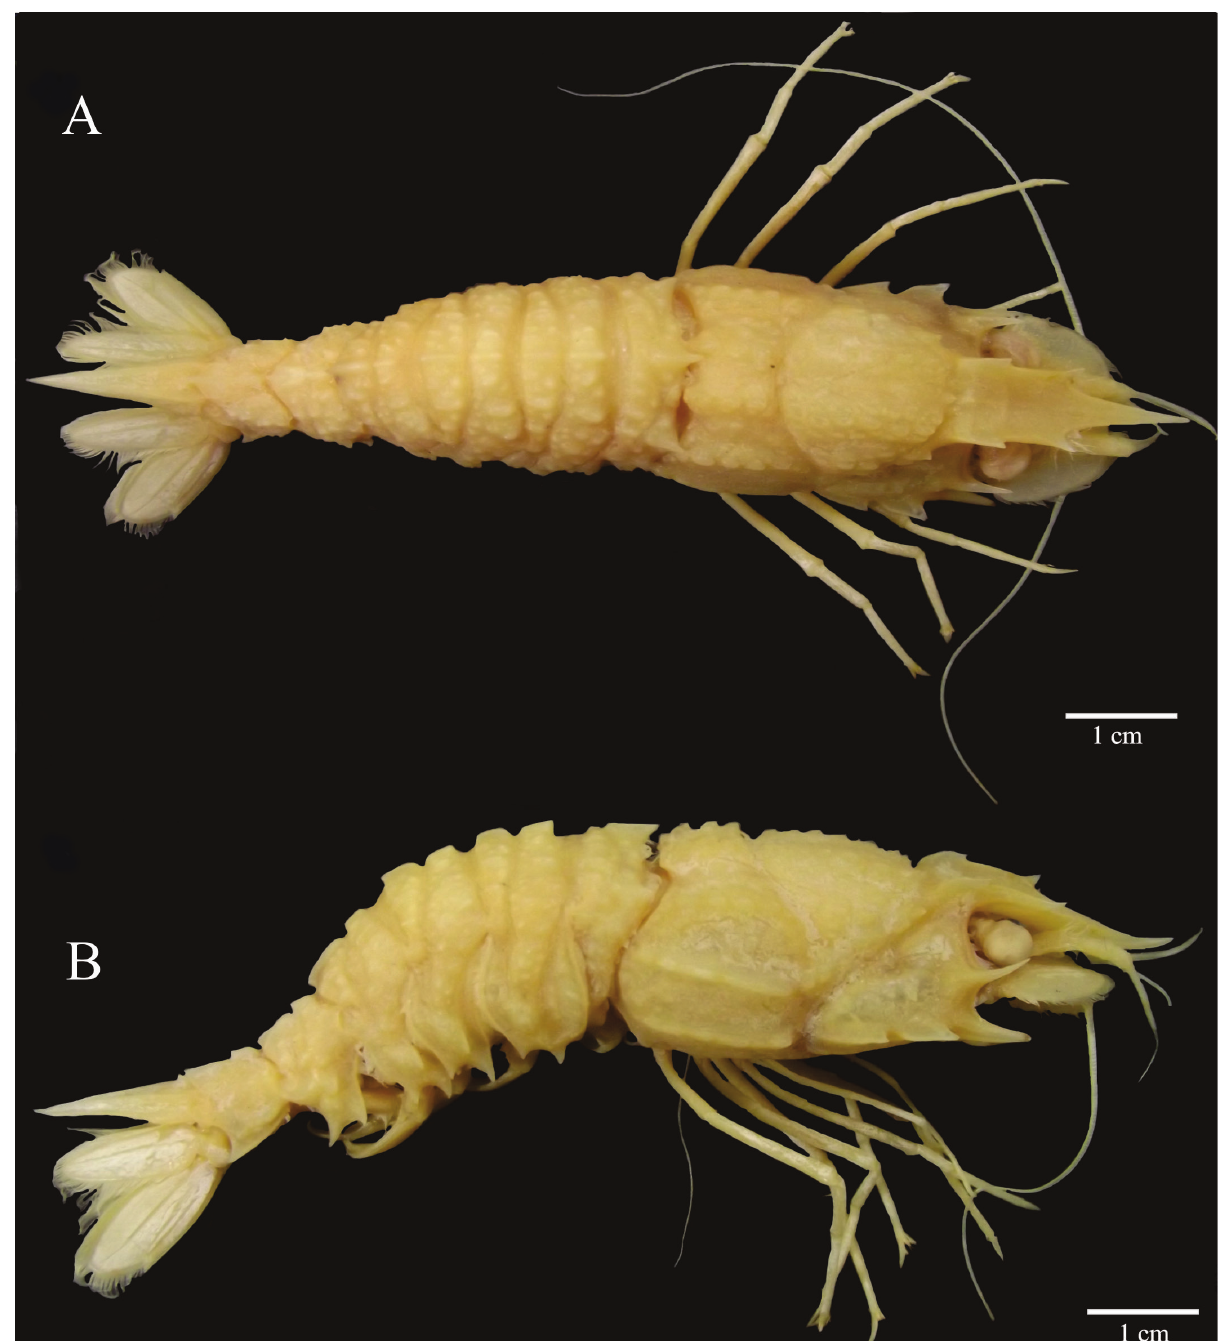
Figure 6. Glyphocrangon spinicauda A. Milne-Edwards, 1881, dorsal (A) and lateral (B) views, female (TL-62.5 mm; Bpot-Talude MT# 65; MOUFPE 15.188), northeastern